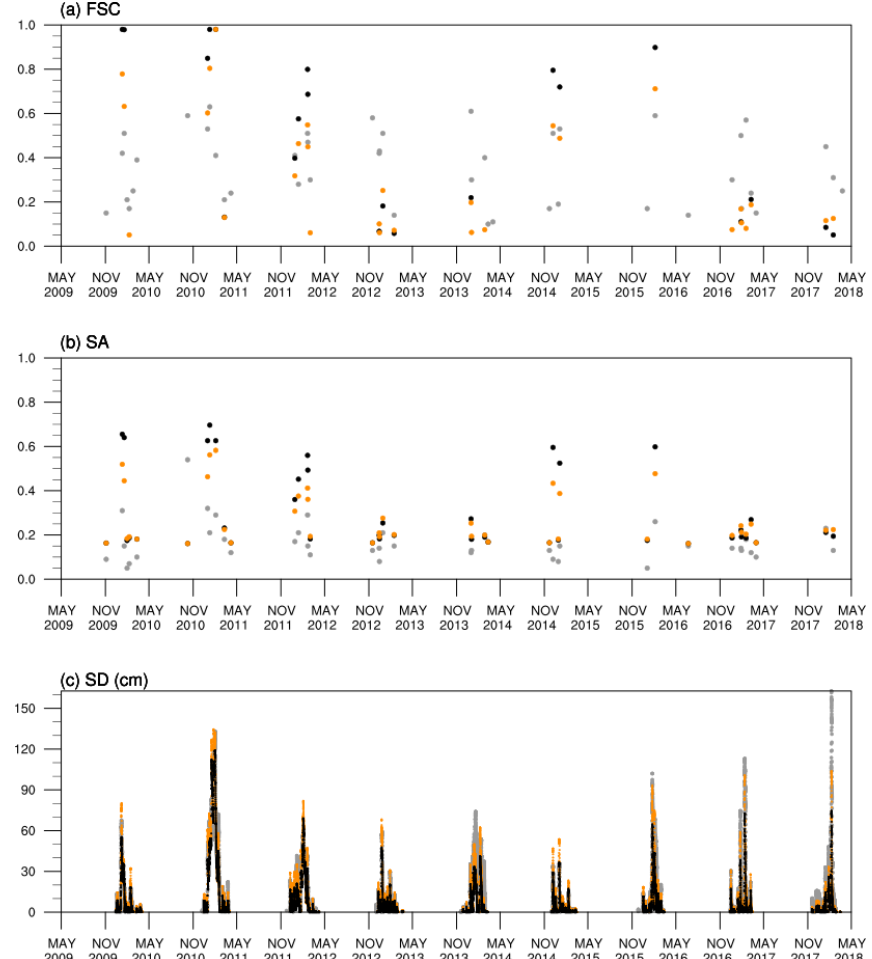
Figure 7. Time series of the snow variables for DBF (e.g., UL) from May 2009 to April 2018: (a) FSC, (b) SA, and (c) SD (cm). Observations are in gray dots, and model results are in black dots for CNTL and in orange dots for